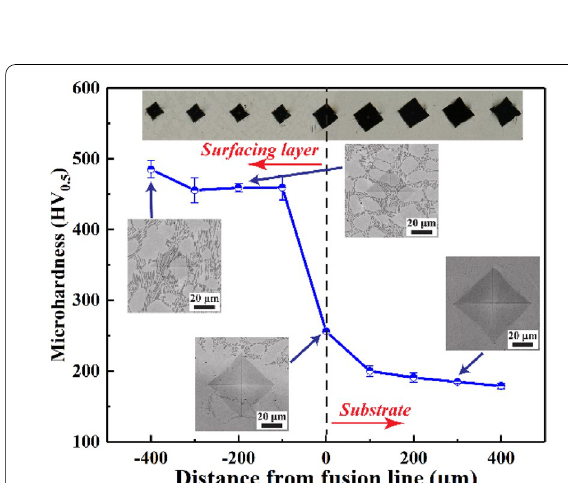
Figure 3 Microhardness from substrate to surfacing layer